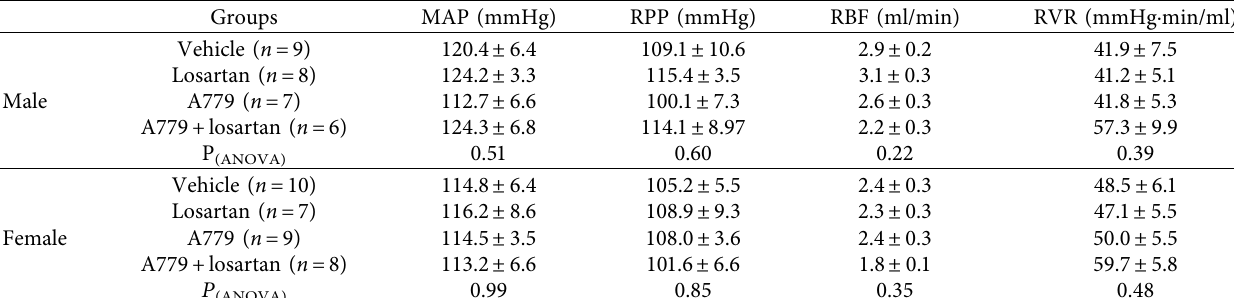
Table 2: The baseline hemodynamics